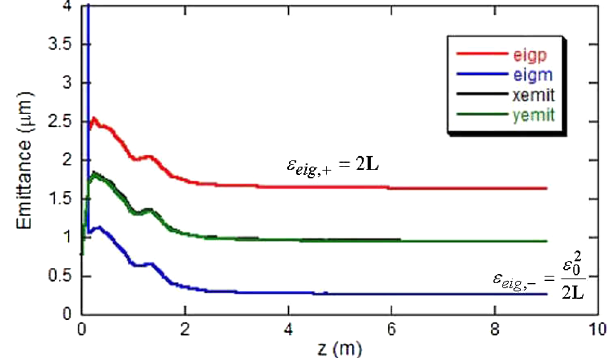
FIG. 12. Flat-beam transform configuration. A solenoid gen- erates an axial magnetic field at the location of the cathode. Once the beam leaves the solenoidal field, it encounters three skew quadrupole which remove the x (cid:2) y correlations. This figure is courtesy of Kip Bishofberger.